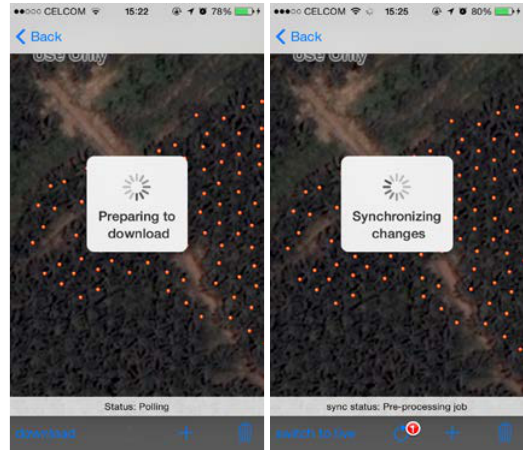
Figure 2. Screenshots of points features that displayed on the screen and the description of one of the point features.